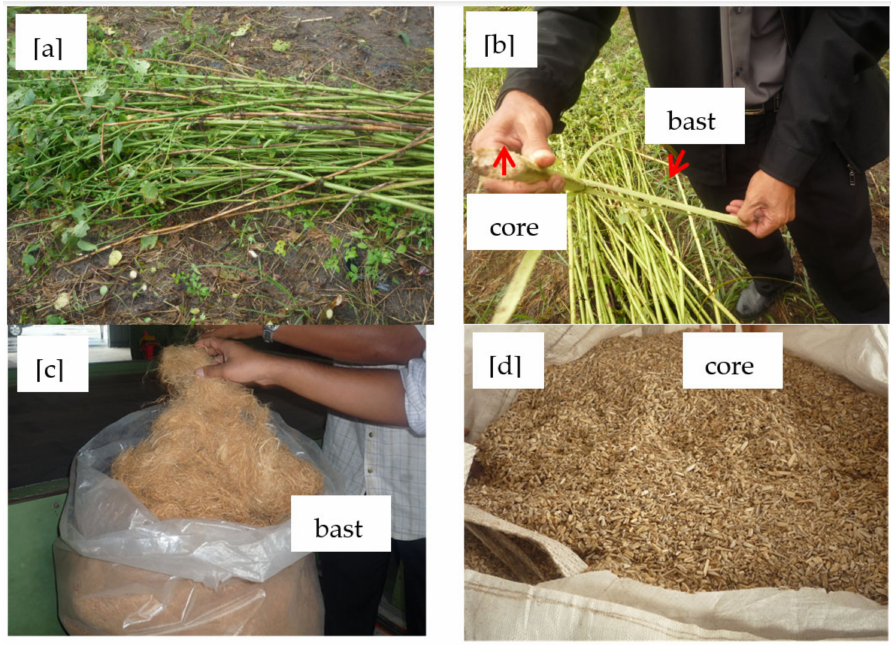
Figure 1. ( a – d ). Picture of kenaf